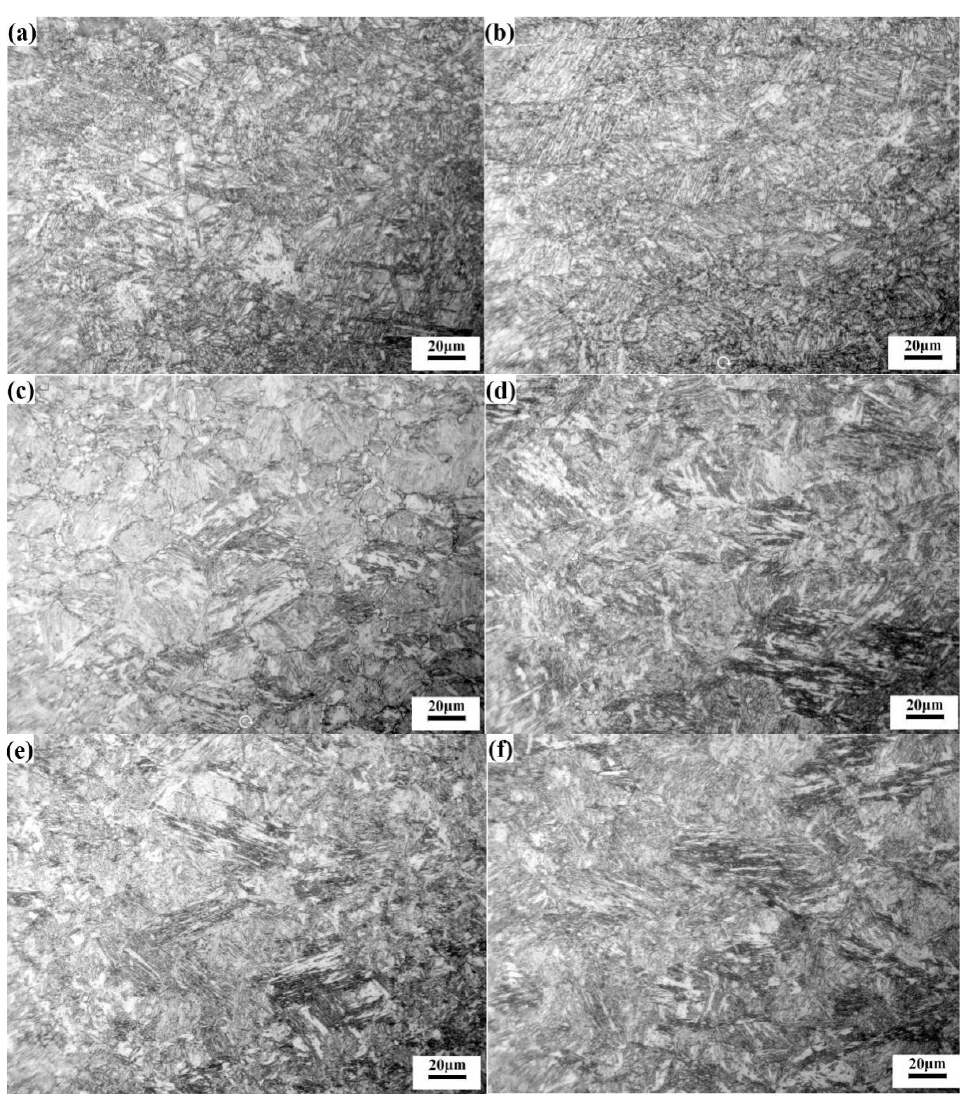
Figure 6. OM images of the fractured specimens at the specified positions: ( a ) position 1 with 500 °C; ( b ) position 2 with 500 °C; ( c ) position 1 with 700 °C; ( d ) position 2 with 700 °C; ( e ) position 1 with 800 °C; ( f ) position 2 with 800 °C.